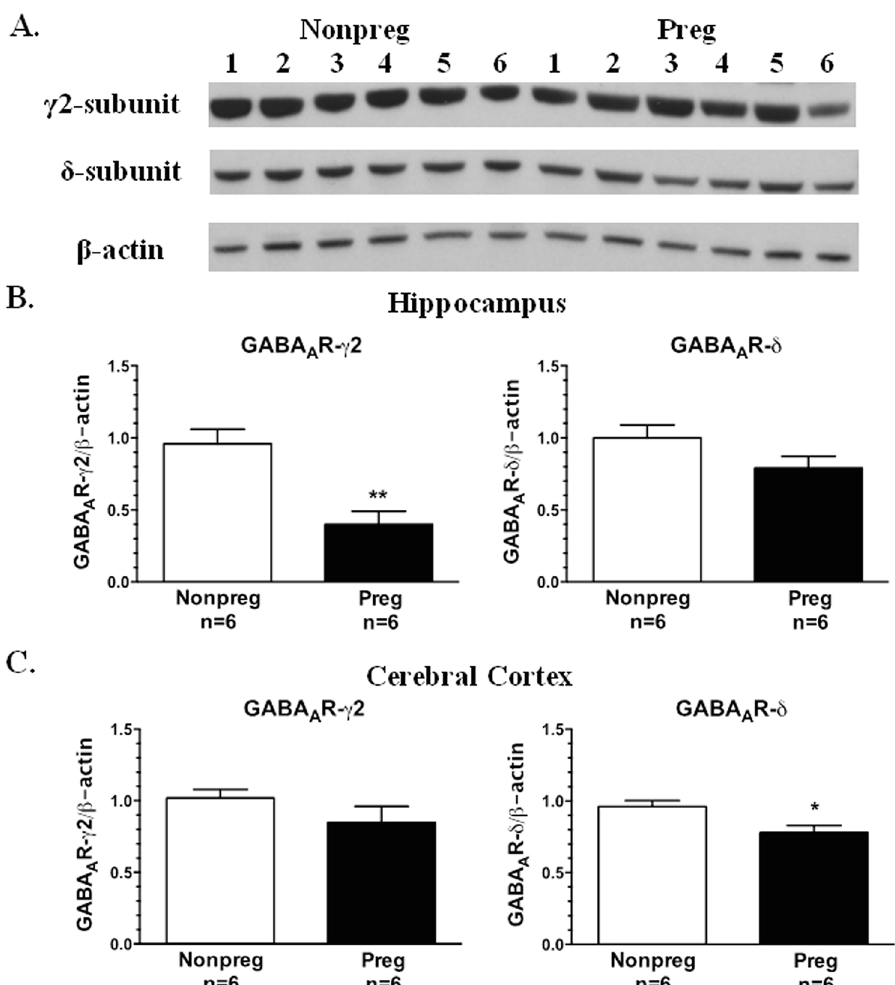
Fig 4. The effect of pregnancy on GABA A R δ - and γ 2-subunit protein expression in the hippocampus and cerebral cortex. (A) Representative Western blots showing protein expression of the GABA A R γ 2-subunit and δ -subunit in the cerebral cortex of nonpregnant (Nonpreg) and pregnant (Preg) rats. (B) GABA A R γ 2-subunit protein expression was significantly lower in the hippocampus from Preg compared to Nonpreg rats, and GABA A R δ -subunit expression trended towards being decreased in the hippocampus of Preg compared to Nonpreg rats. (C) Cortical GABA A R γ 2-subunit expression was similar in Preg and Nonpreg rats, however, GABA A R δ -subunit expression was decreased in the cerebral cortex of Preg compared to Nonpreg rats. ** p < 0.01; * p < 0.05 vs. Nonpreg using Student ’ s